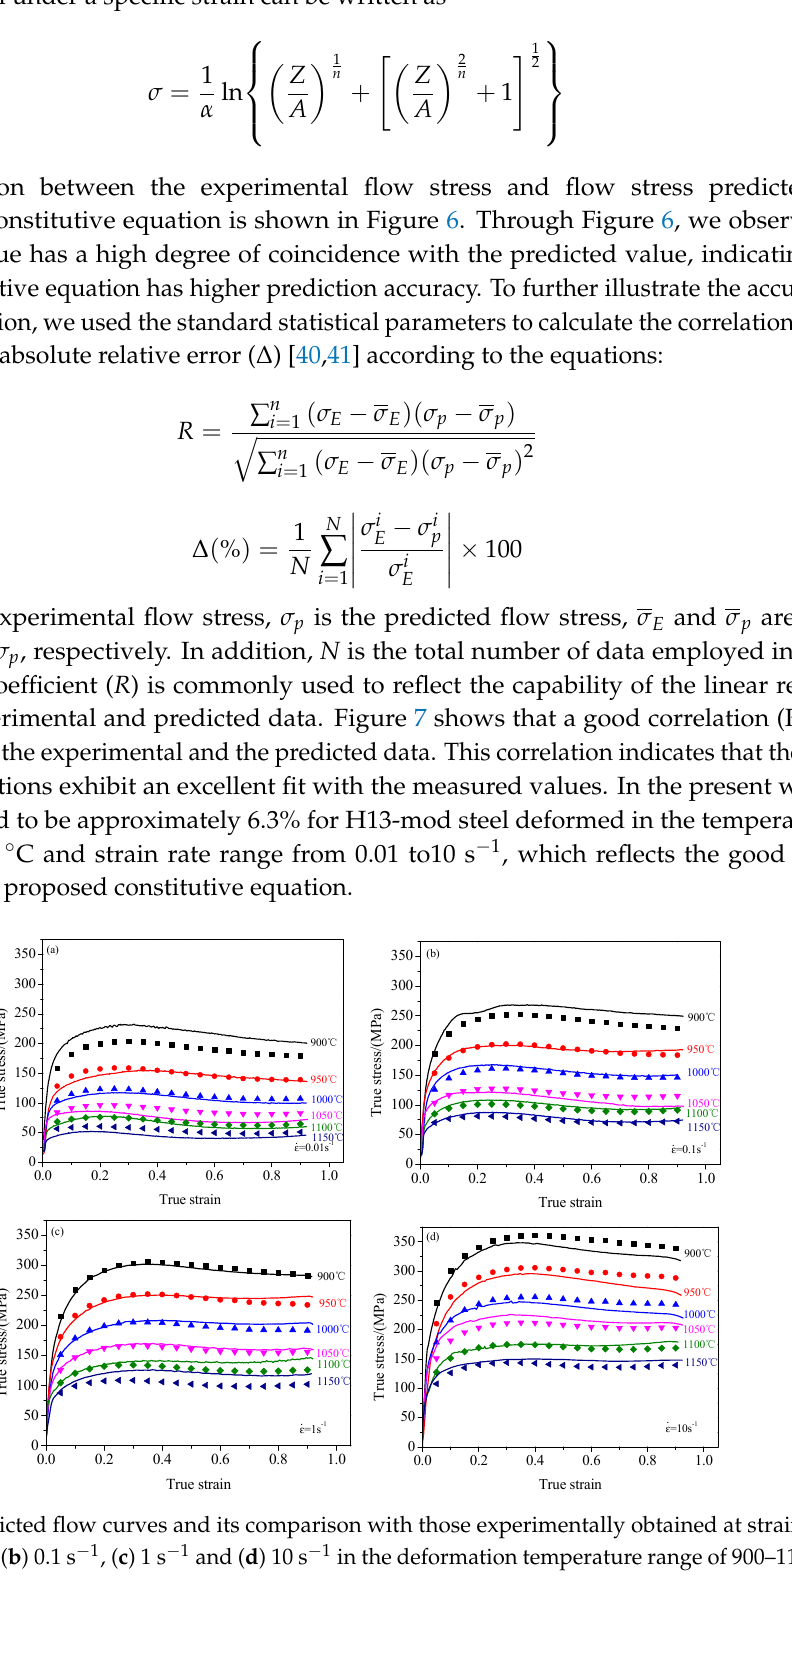
Figure 7. Correlation between the predicted and experimental flow stresses for the strain range of 0.05–0.9 (at intervals of 0.05) over the entire strain rate (0.01–10 s − 1 ) and deformation temperature range (900–1150 °C). Jorge and Balancin [42] suggested that the mechanical parameters can be described by simple Zener parameters. Moreover, this method is being cited in an increasing number of literature works. The Z parameters and these mechanical performance parameters can be described by the following power exponential equation: